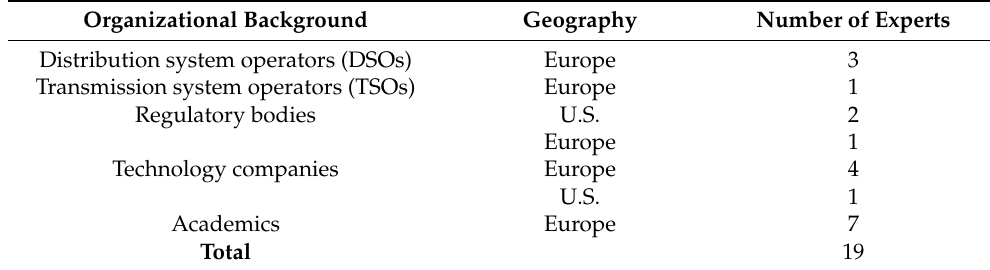
Table 1. Power grid experts interviewed for the risk assessment: background and geography. Organizational Background Geography Distribution system operators